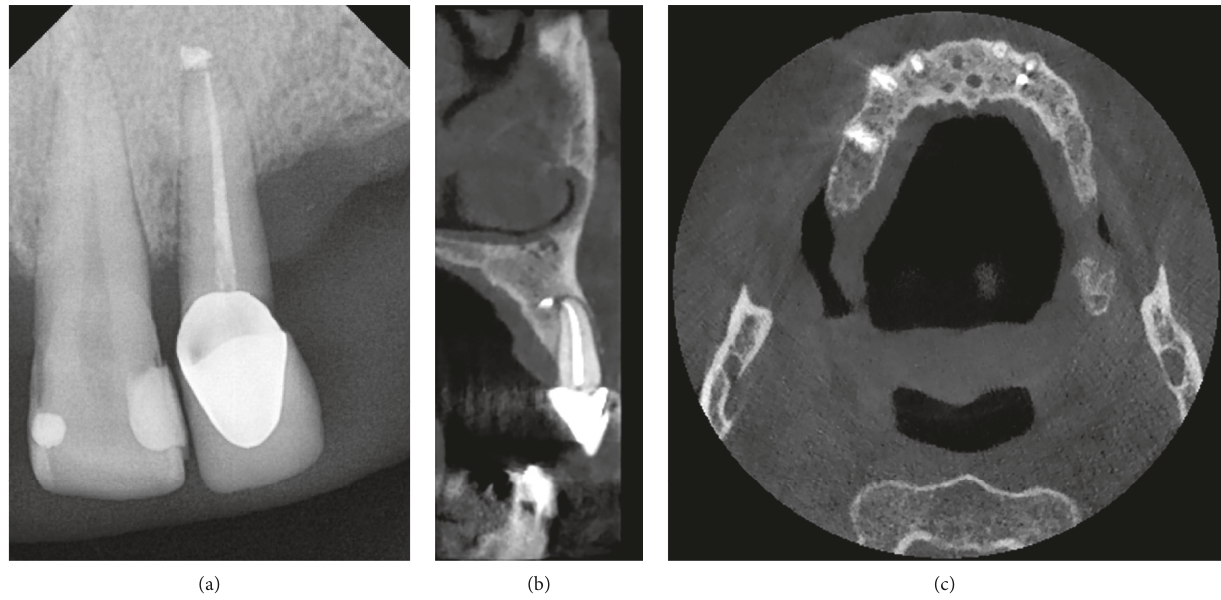
Figure 2: Endodontic treatment 2.2. (a) Periapical X-ray: endodontic overfilling and no periapical radiolucency. (b) CBCT sagittal cross section: apex endodontic treatment, over filling, and periapical radiolucency. (c) CBCT transversal section: over filling and periapical radiolucency.